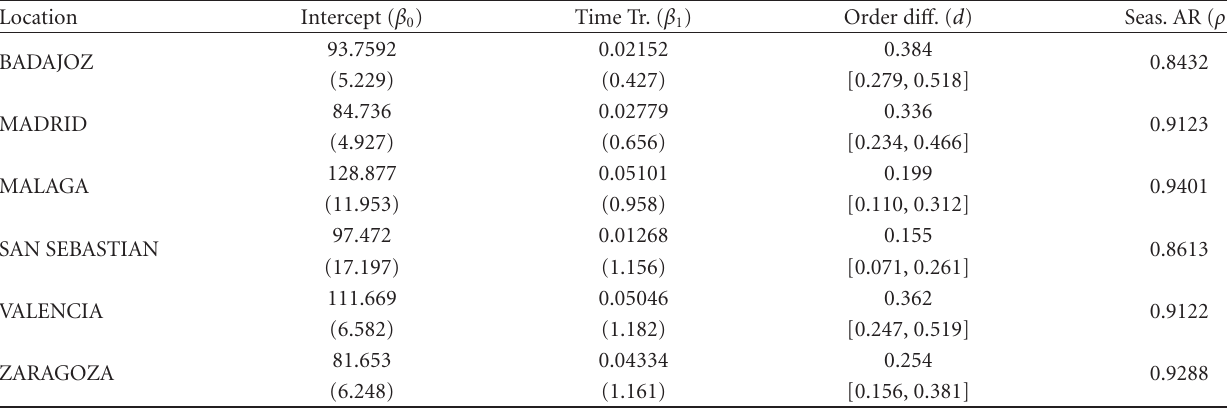
Table 2: Estimates of the time trend coe ffi cients, the fractional di ff erencing parameters and the seasonal AR(1) coe ffi cients. Series: T min . t -values in parenthesis. In brackets the 95% confidence bands for the orders of integration.)